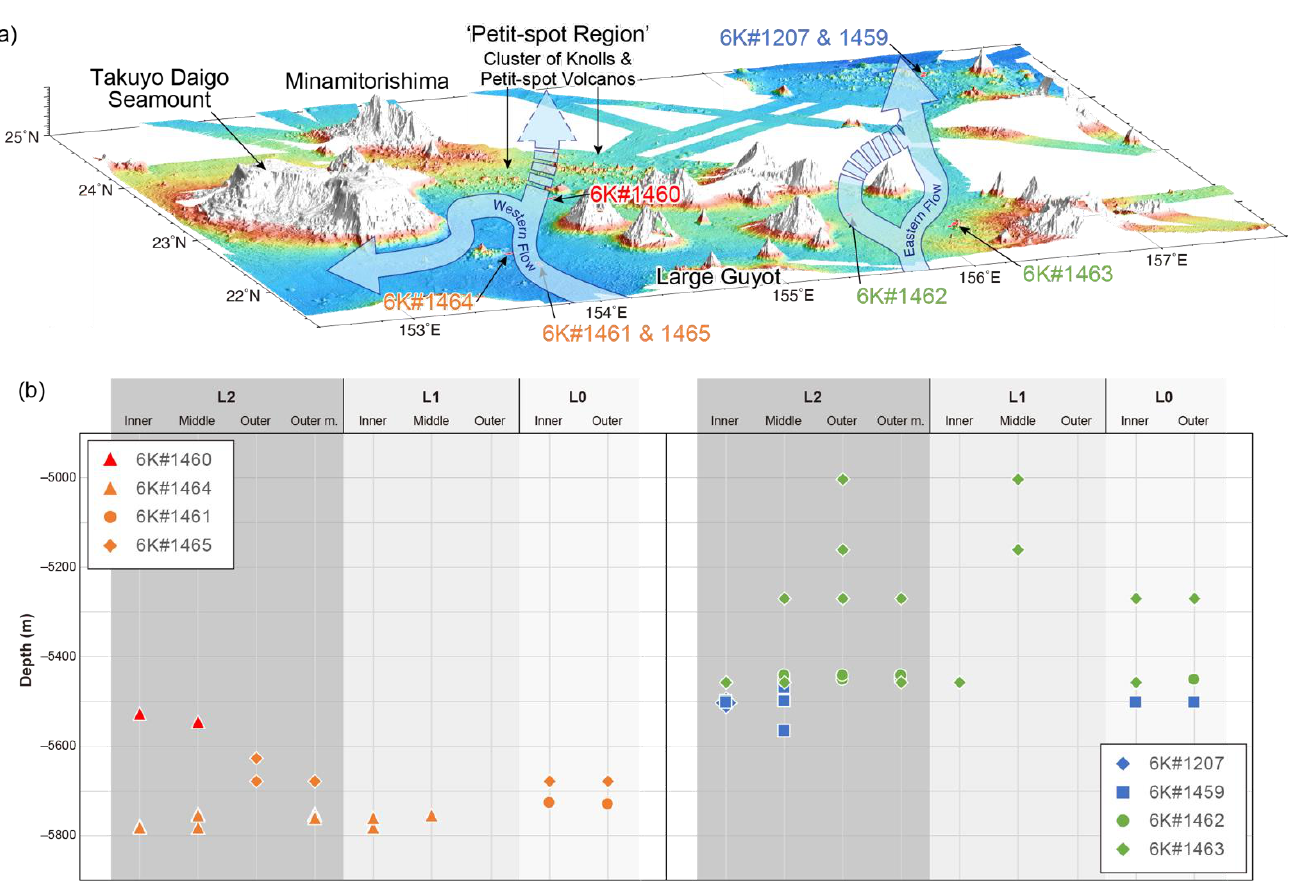
Figure 6. Expected flow direction of deep-sea currents that had intermittently supplied materials to be the nuclei of nodules in the regions around Minamitorishima Island. ( a ) Three-dimensional map portraying detailed topography and sampling sites viewed from S40°W. Bathymetric data and the color scale as same as in Figure 2. ( b ) Relationships between depth of sampling site (Table 1 and Figure 2) and the innermost layer (i.e., layer around the nuclei) of each different-sized nodule (Figure 5).